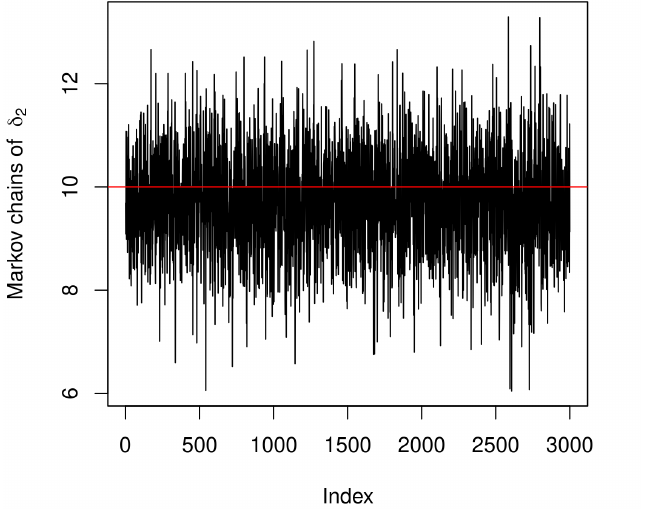
Figure 3. The Markov chains of δ 2 . The horizontal line is the true value of δ 2 .